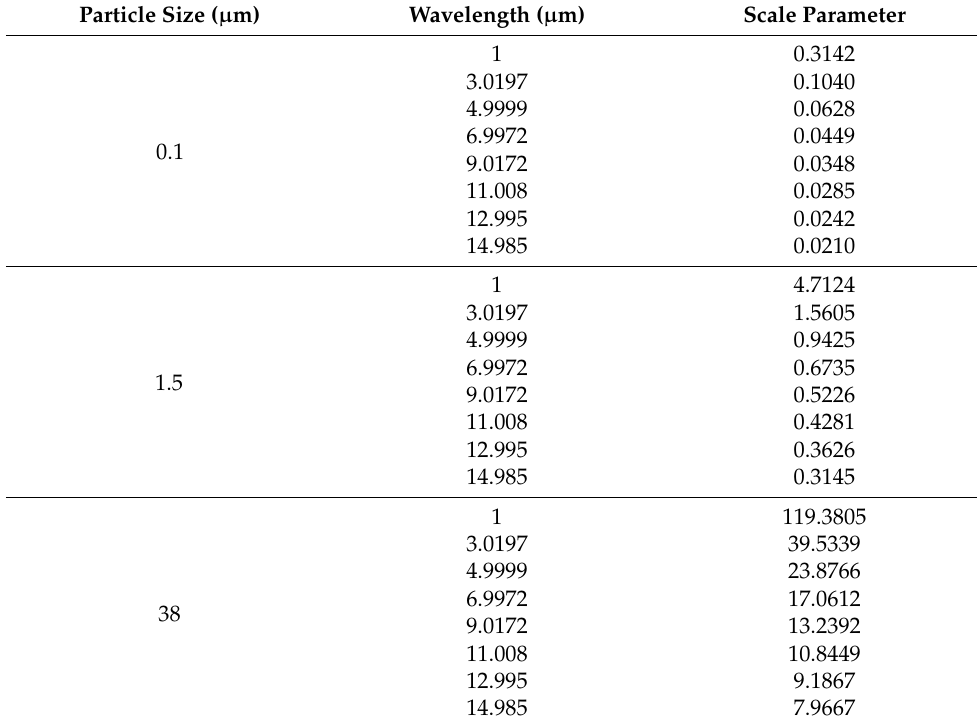
Table 1. Relationship between d, λ and χ